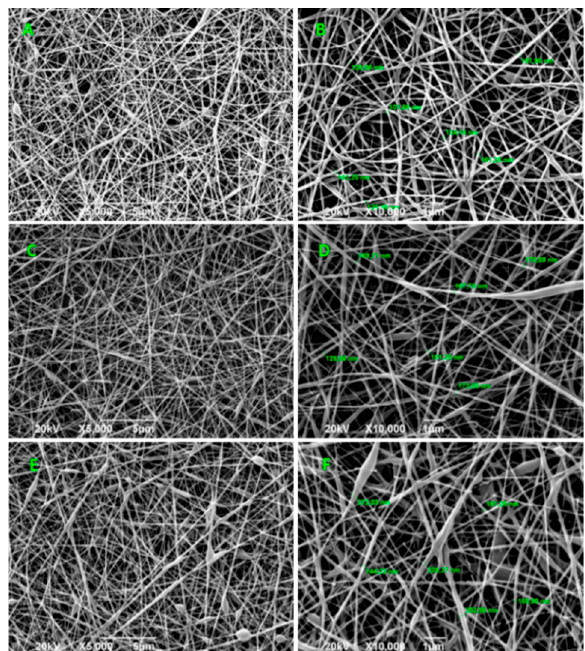
Figure 2. SEM images of electrospun CS/PVA/GO composite nanofibrous membranes with different GO amounts (0%, 0.5%, and 1.0%). Images A, C, and E at 500×, and images B, D, and F at 10,000×. For all the experiments, the voltage used was 20 kV.